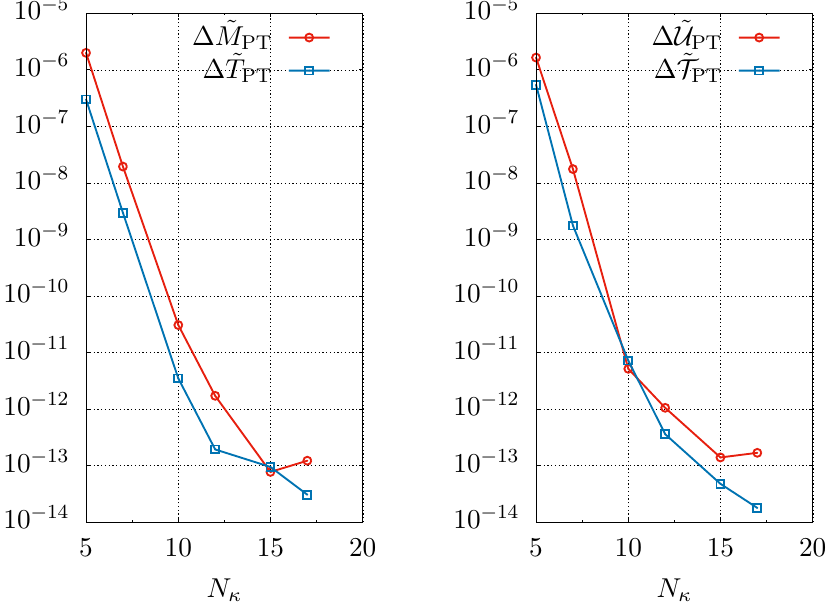
Figure 7 . Convergence of the numerically obtained values of the (cid:12)rst order phase transition between the localized and the uniform phase. We show the di(cid:11)erences to the values of the regarding quantity obtained with N (cid:20) = 20 Lobatto points normalized by this